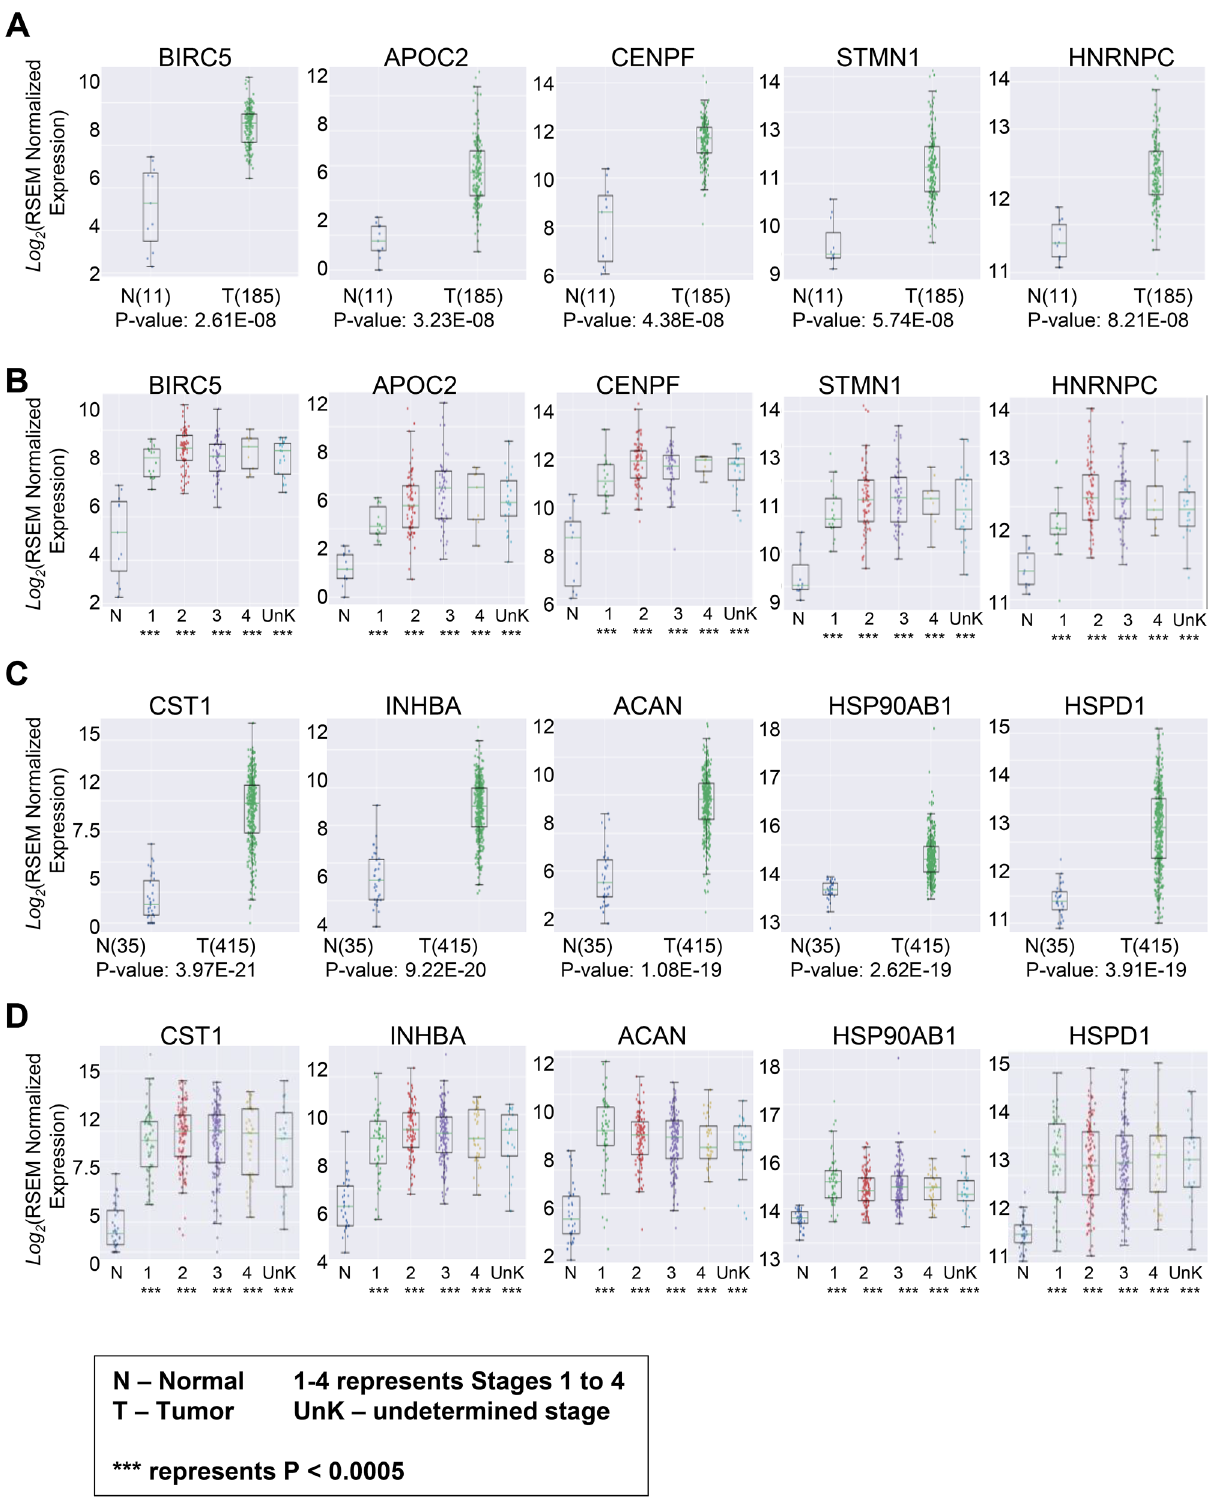
Figure 1. ( A ) The comparison between patients with esophageal cancer versus control individuals showed significant overexpression BIRC5, APOC2, CENPF, STMN1, and HNRPC in patients with esophageal cancer. ( B ) BIRC5, APOC2, CENPF, STMN1, and HNRPC significantly overexpressed across all stages in patients with esophageal cancer. ( C ) The comparison between patients with stomach cancer and healthy control showed significant overexpression of CST1, INHBA, ACAN, HSP0AB1, and HSPD1 in patients with stomach cancer. ( D ) Assessment of CST1, INHBA, ACAN, HSP90AB1, and HSPD1 in different stages of stomach cancers showed a significant overexpression of these genes across all stages in patients with stomach